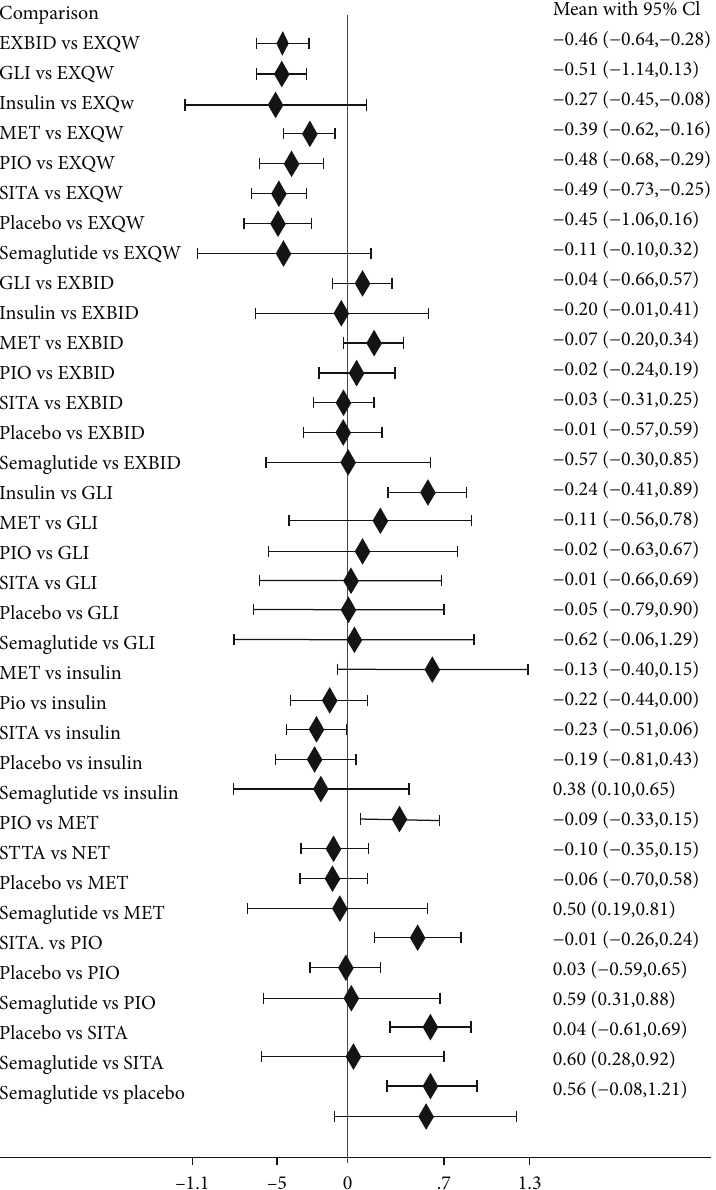
Figure 3: Results of network meta-analysis on HOMA- β